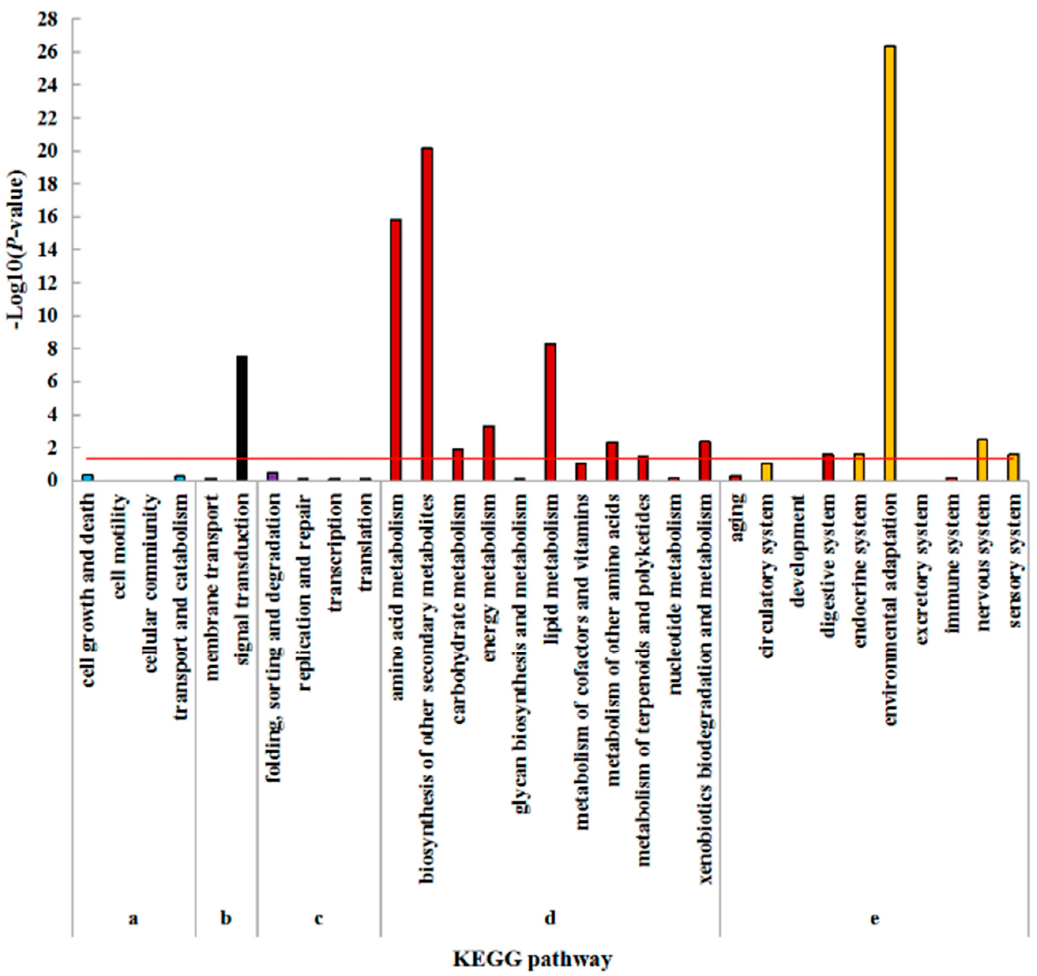
Figure 5. KEGG pathway enrichment analysis of DEGs in roots under N- compared with CK. ( a ) Cellular processes; ( b ) Environmental information processing; ( c ) Genetic information processing; ( d ) Metabolism; ( e ) Organismal systems. The hypergeometric distribution calculates the p -value which determines the significance of enrichment, and the red line represents the p- value of 0.05.